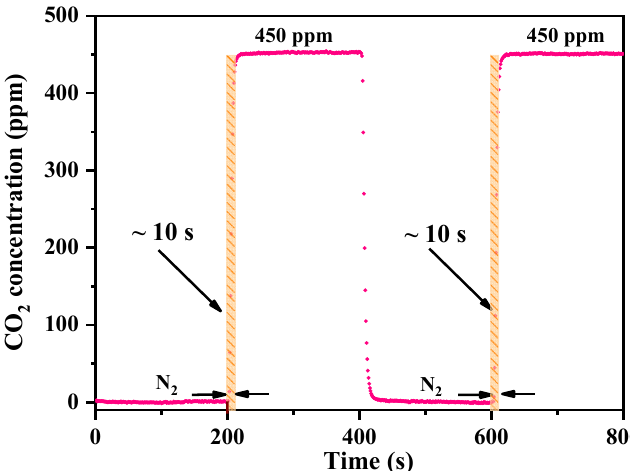
Figure 7. Response time of the miniaturized TDLAS system.